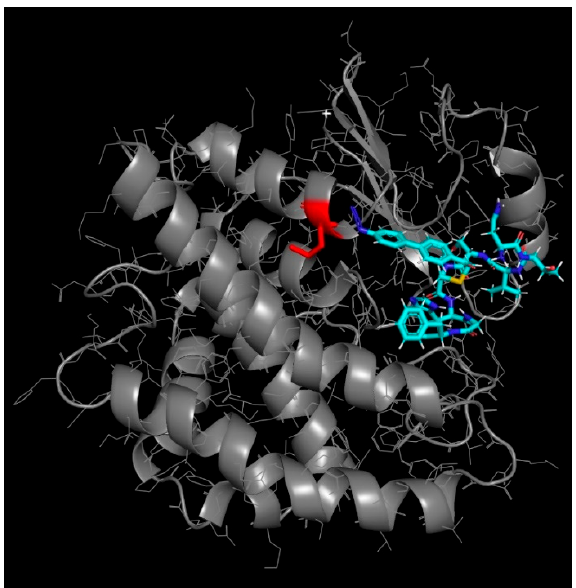
Figure 5. Molecular docking simulation of the caged binder (shown as a stick; C, N, O and S atoms are highlighted by cyan, blue, red and yellow colors, respectively) to GST (PDB ID: 1UA5) using the sievgene of myPresto; the best docking model with a lowest binding energy of − 12.0 kcal/mol was presented. The azido group (i.e., N 3 ) in the caged fluorophore and conjugated methionine in GST were colored in blue (double-lined) and red, respectively. GST was shown as a cartoon with side chains as a line description. Including this lowest model, 23 independent models out of the 30 separate poses resulted that the azido group was also closely located to the methionine.